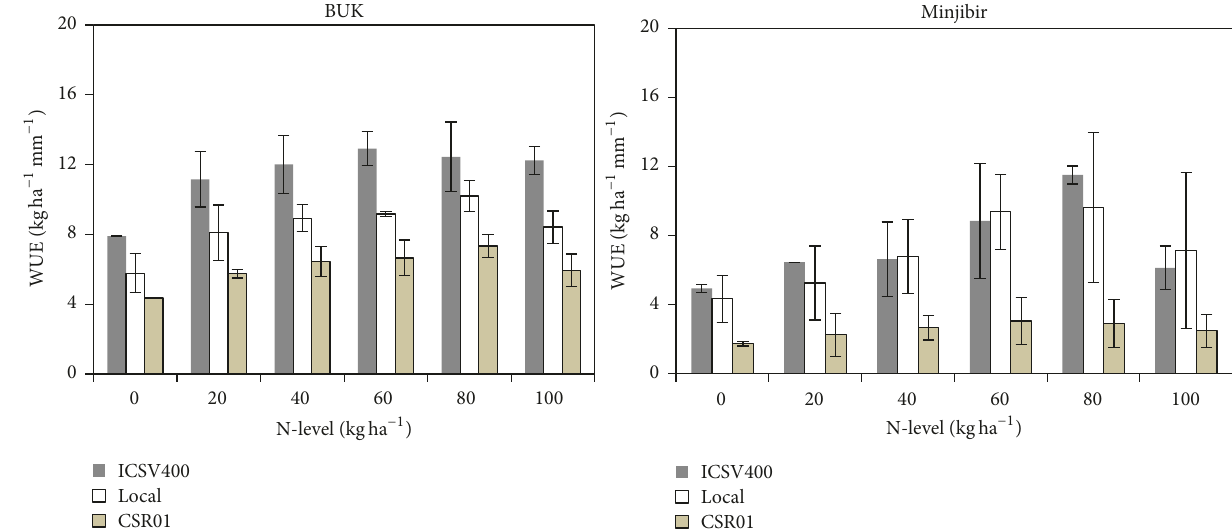
Figure 2: Effects of N-fertilizer rates on water use efficiency (WUE) of selected sorghum varieties in Sudan Savanna zone. P of F equals 1.000 in BUK and 0.011 in Minjibir .